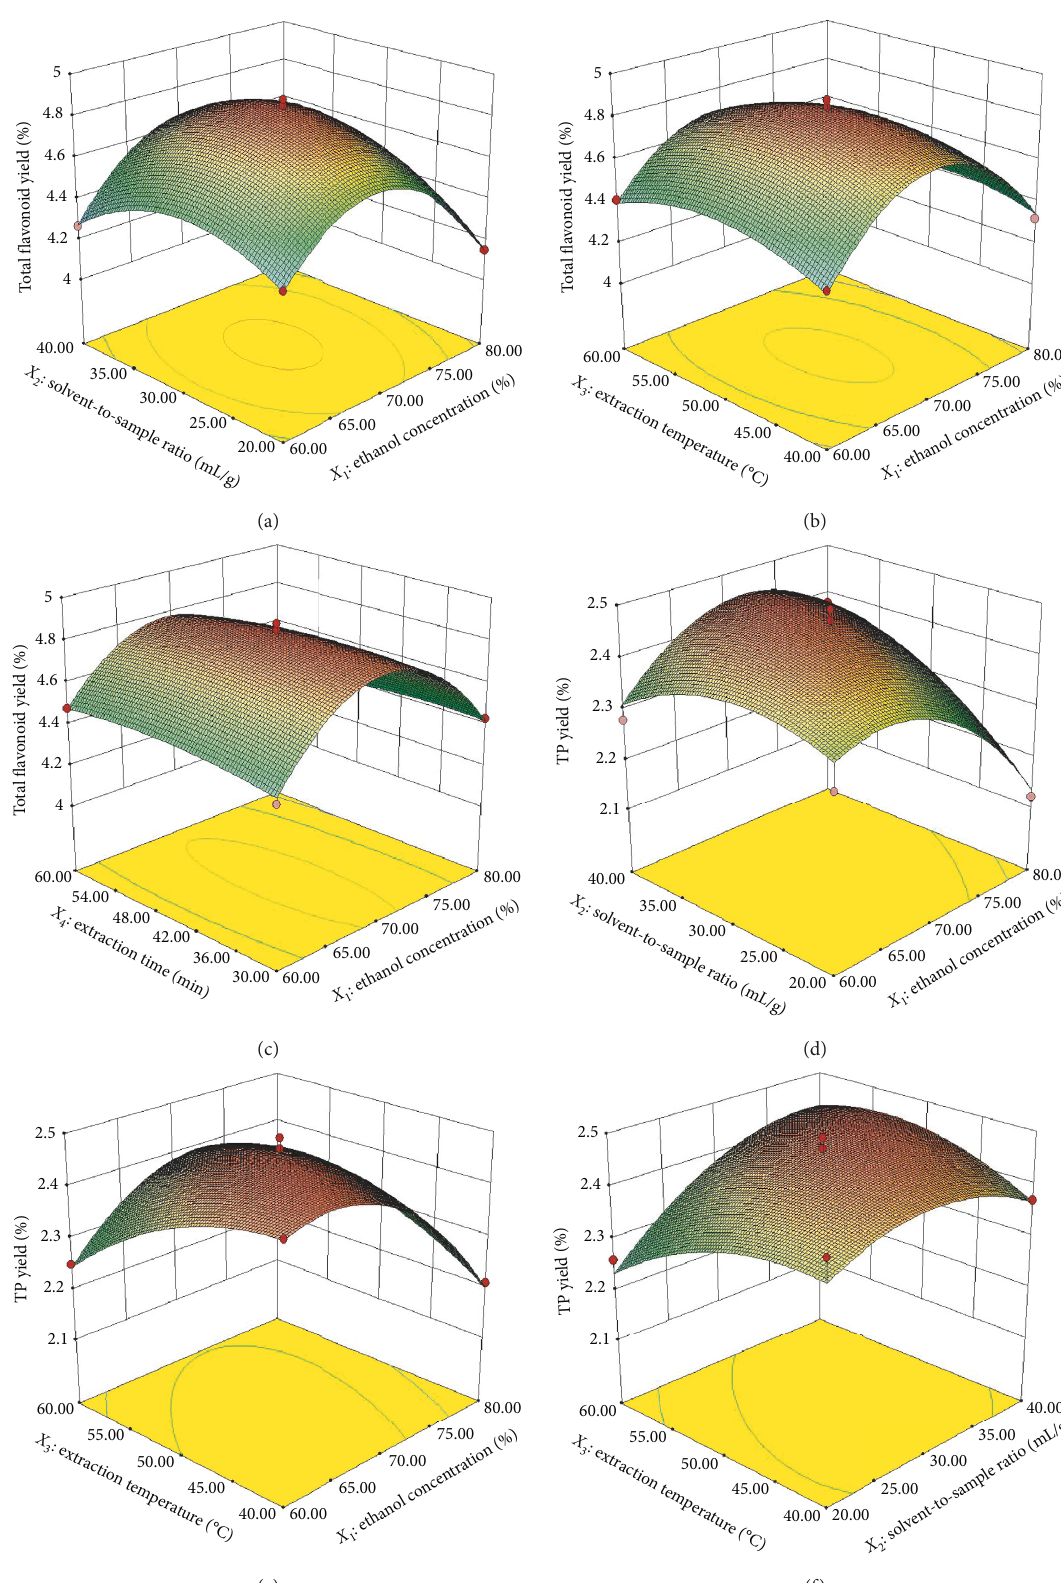
Figure 1: Interactive effect of extraction variables on (a–c) TF and (d–f)